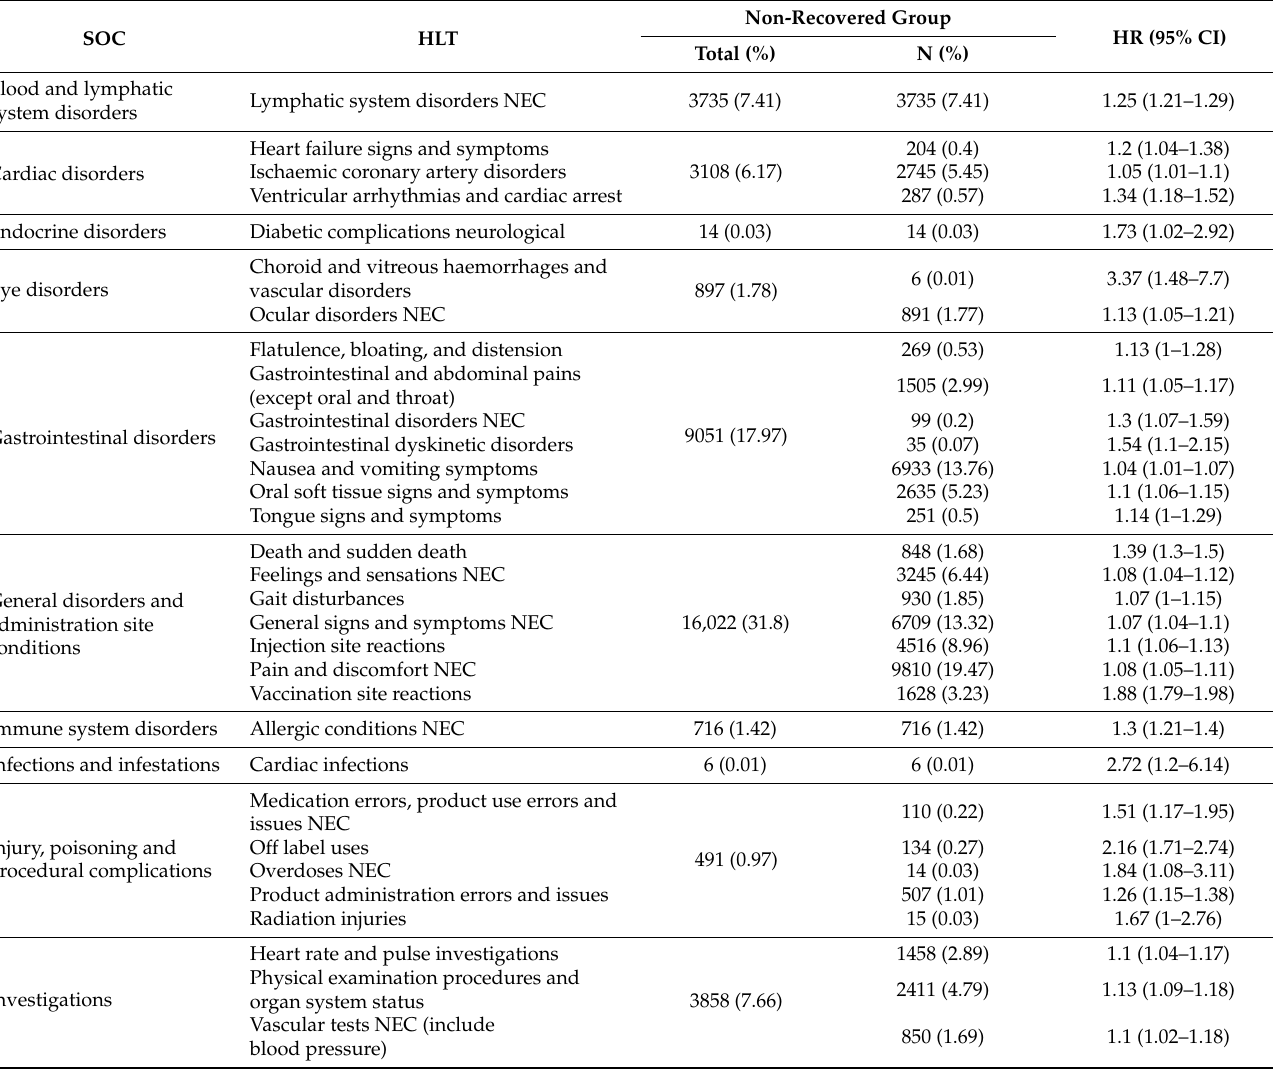
Table 4. AEFIs related to delayed recovery after receiving the Pfizer-BioNTech COVID-19